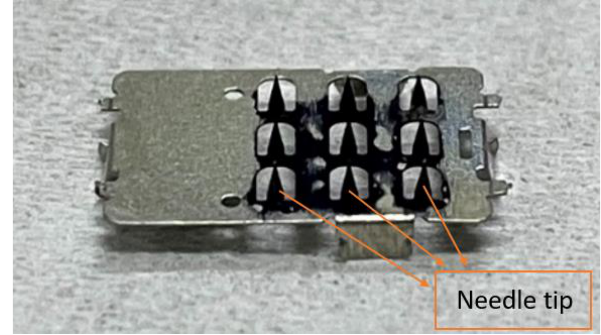
Figure 3. Physical image of the percutaneous microneedle array as a working electrode.